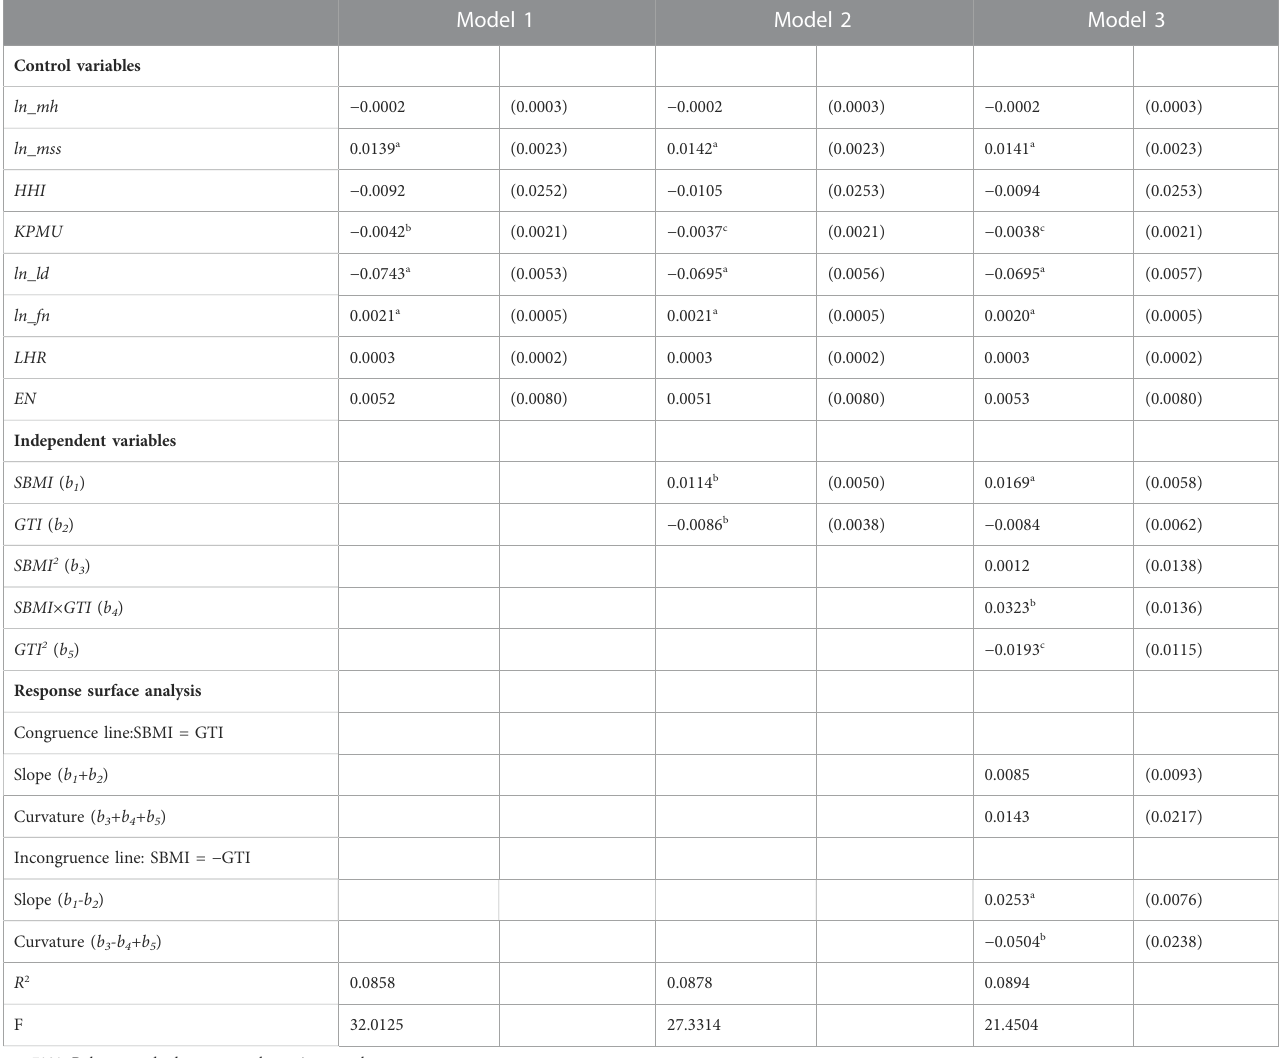
TABLE 3 Results of polynomial benchmark regression and response surface